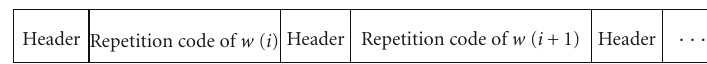
Figure 6: Watermark structure after RHC.